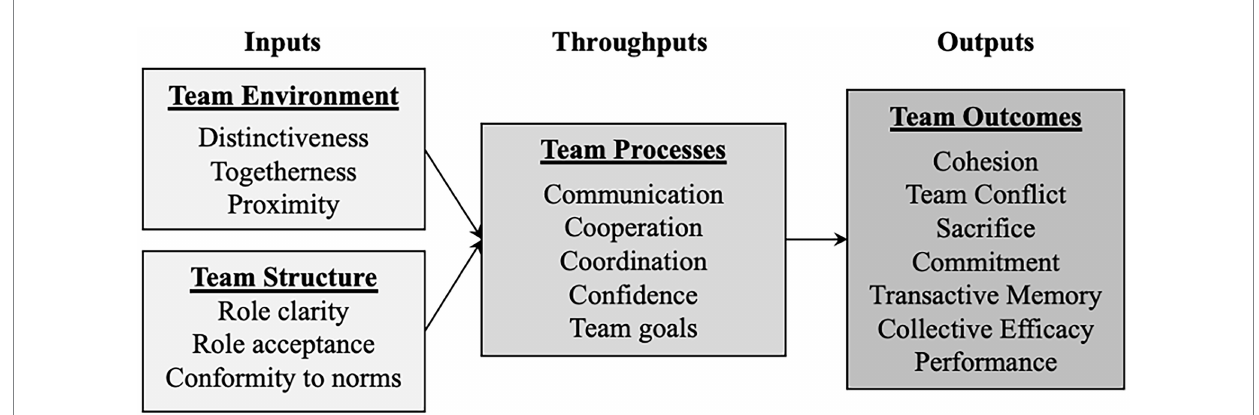
FIGURE 1 Conceptual model for team building in sport [Adapted From Carron and Spink